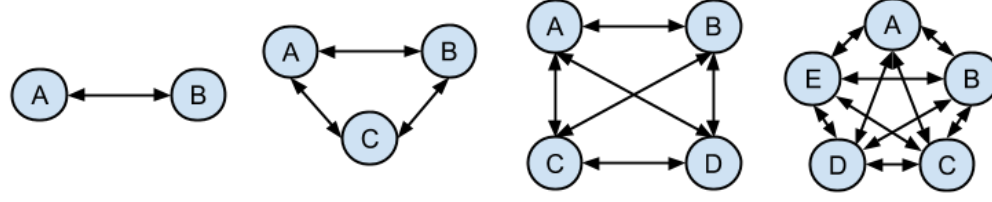
Figure 4. Increase in computation due to the increased amount of points. Source: the